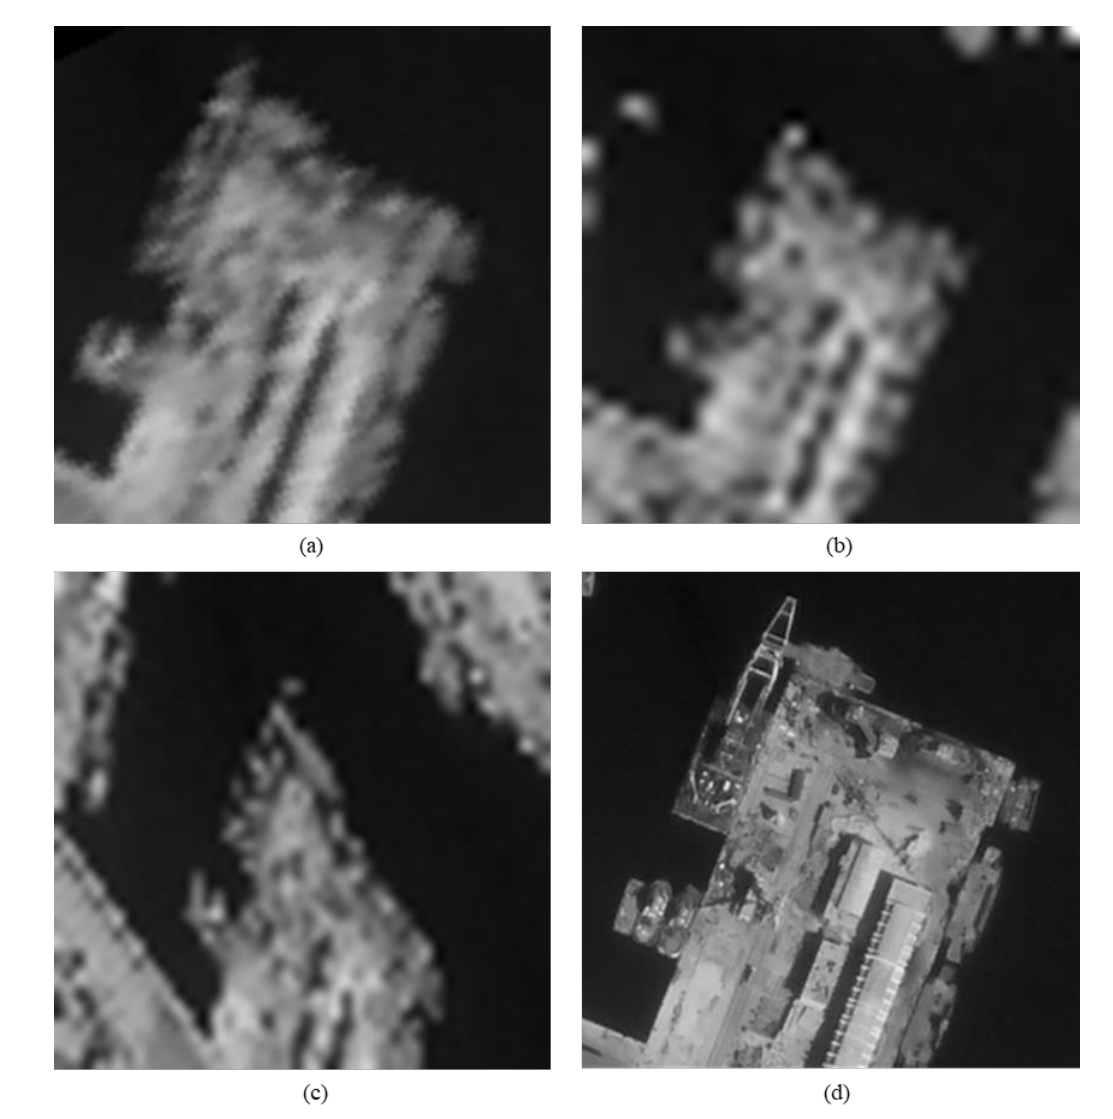
Figure 14. The local magnification of the seashore remote-sensing image: ( a ) super-resolution image, ( b ) conventional mode simulation image, ( c ) CMOS1 oblique-mode simulation images, ( d ) original high-resolution image.